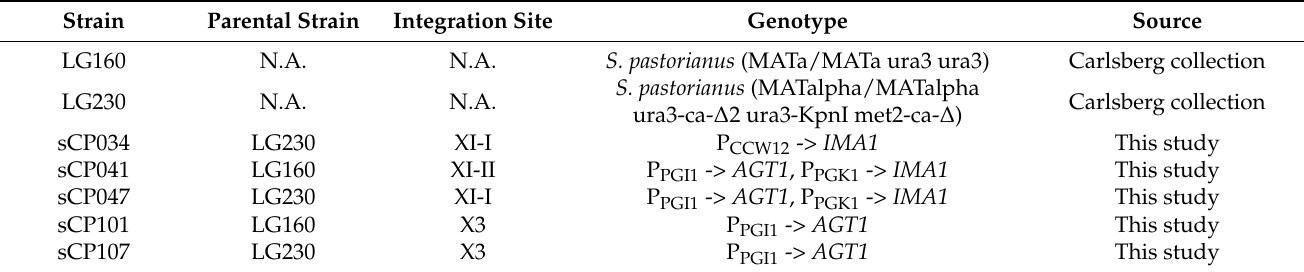
Table 1. Strains used in this